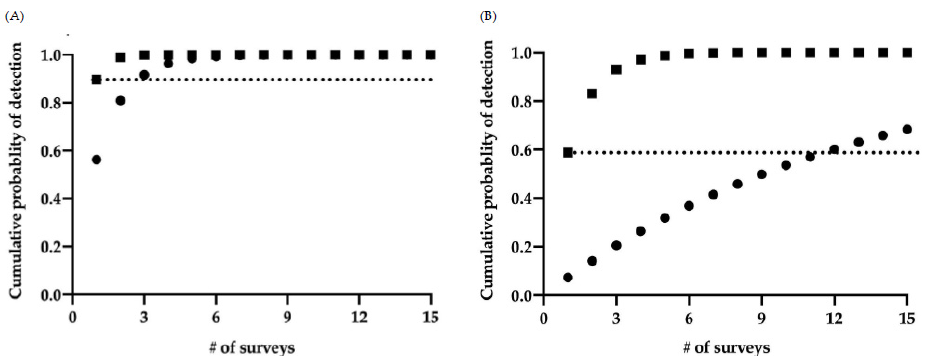
Figure 4. Cumulative probability of detection of citizen scientists surveys (circles) compared to ARUs (squares) for boreal chorus frogs Pseudacris maculata ( A ) and wood frogs Lithobates sylvaticus ( B ). Where the dashed line intersects the circles indicates the number of surveys that would need to be completed by citizen scientists to equal the single survey probability of detection for ARUs.